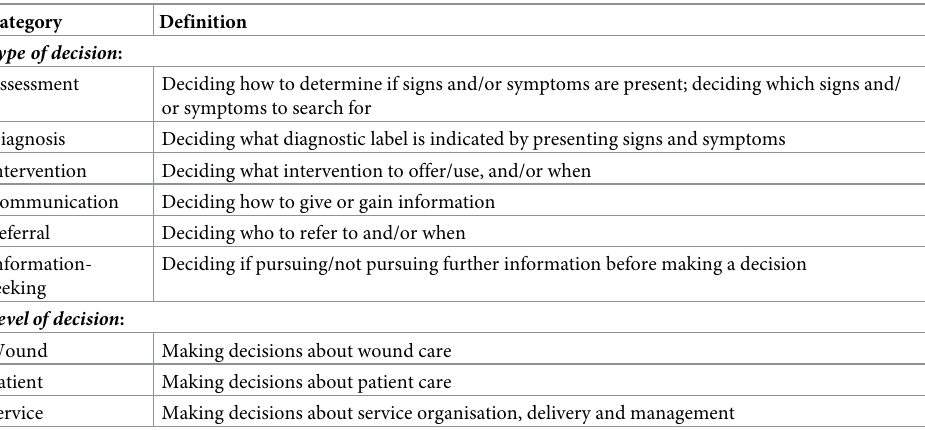
Table 1. Decision typology